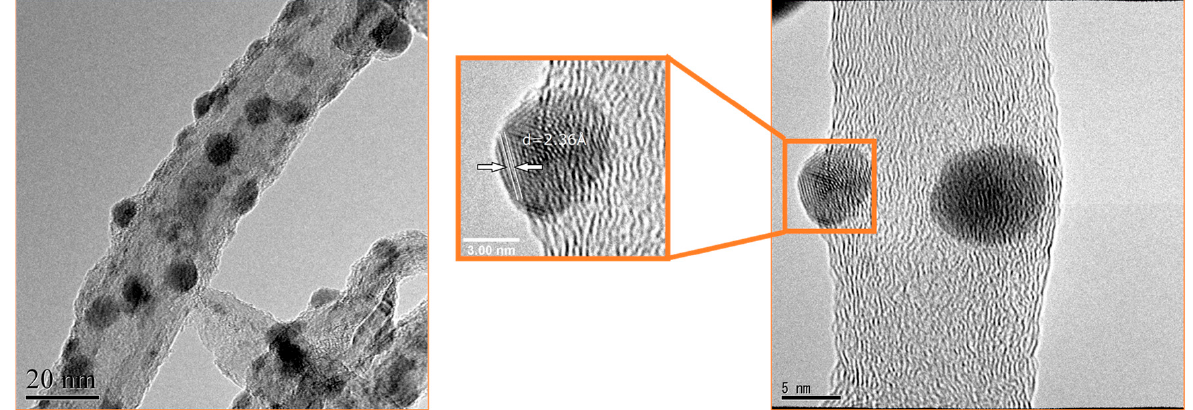
Figure 3. TEM micrographs of AgNP/MWCNT nanocomposites.